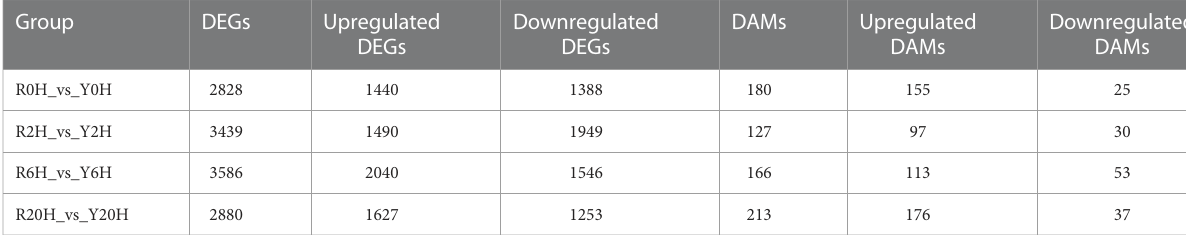
TABLE 1 Summary of the differentially expressed genes and differentially accumulated metabolites.